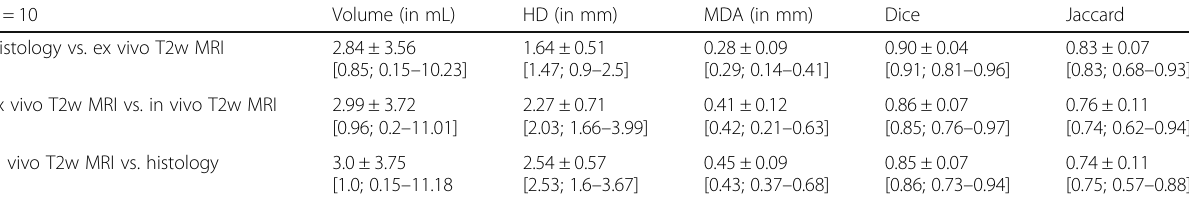
Table 2 Accuracy of BPH nodule registration across mpMRI and histology N =